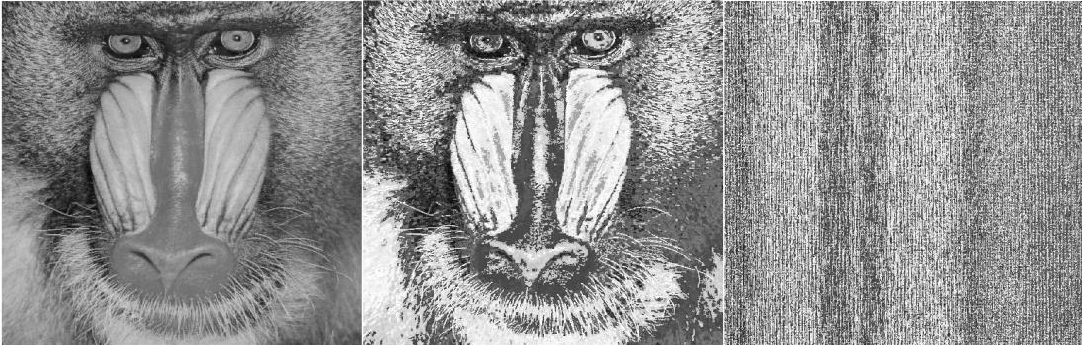
Figure 5. Encryption of Mandrill image. From left original grayscale image, XORed Image, and scrambled image with configurations 𝑅 = 𝑒(𝐼 ′ , 𝐿 0 , 𝑣 𝐶𝐺𝐿 , 𝑃𝐵𝐶, 12,7) .